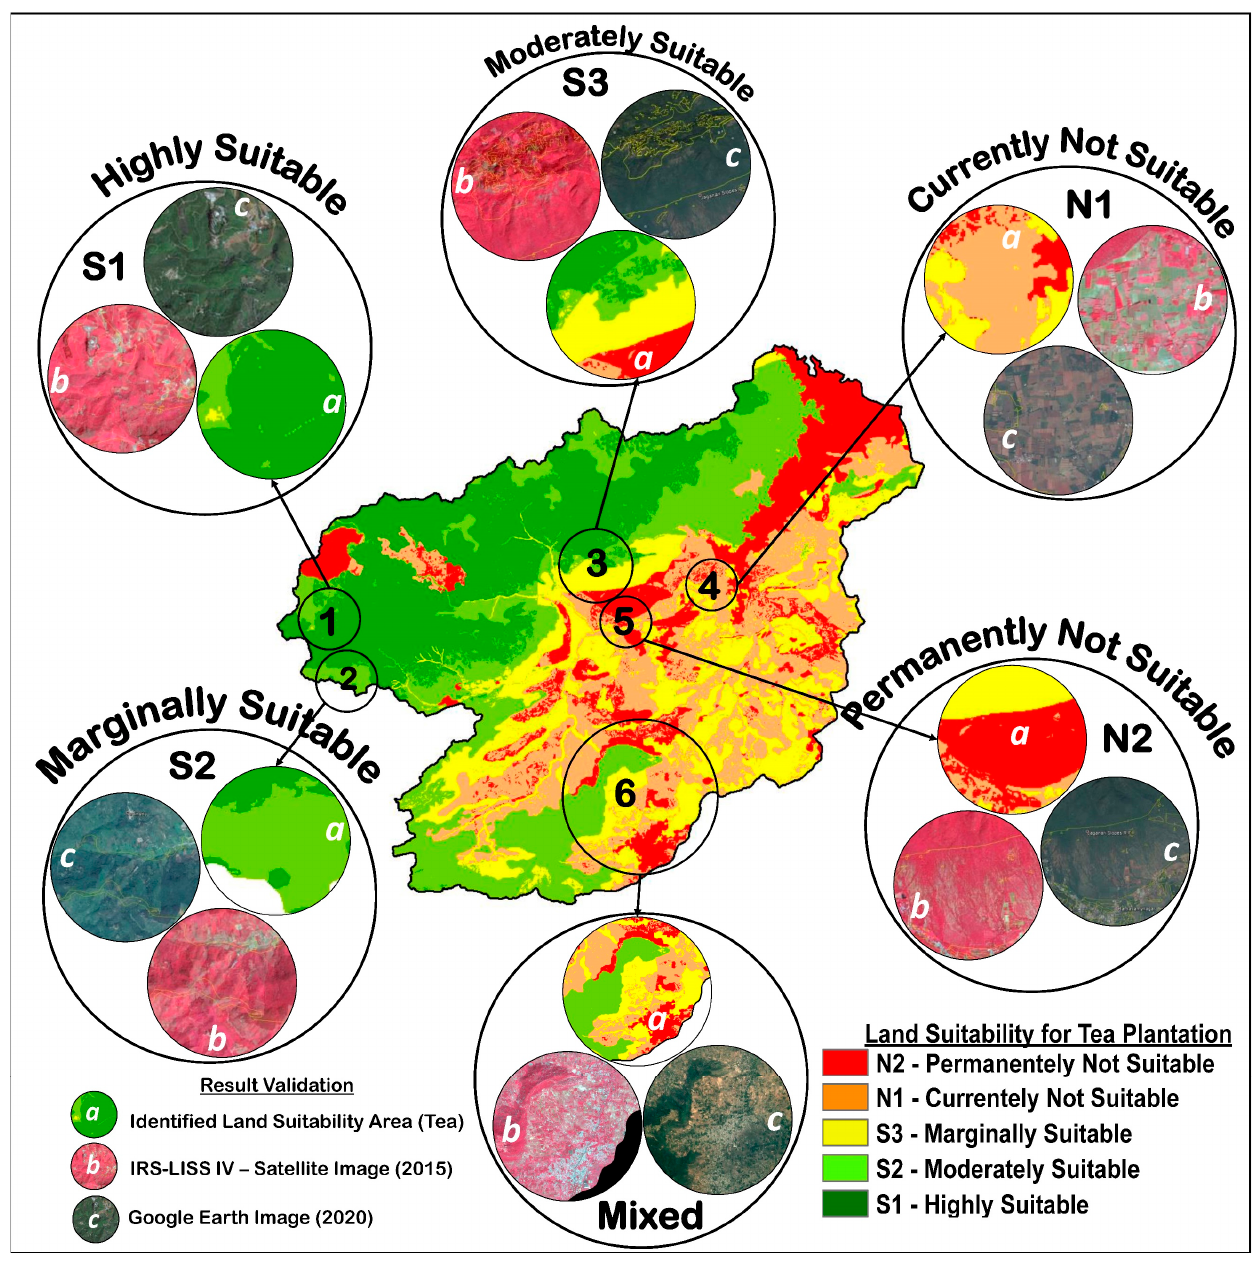
Figure 9. Comparative validation. (a) Resultant suitability layer, (b) LISS 4 satellite image, and (c) Google Earth image. Each circle depicts the comparative suitability classes, 1: highly suitable (S1), 2: moderately suitable (S2), 3: marginally suitable (S3), 4: currently not suitable (N1), 5: permanently not suitable (N2), and 6: Mixed suitability classes.